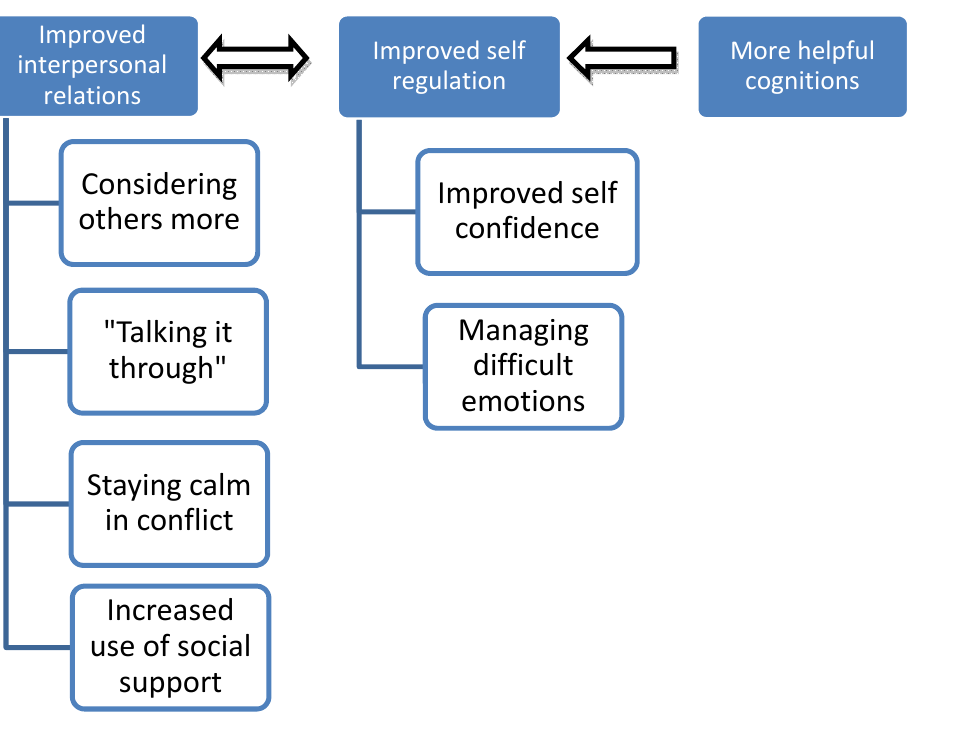
Figure 1. Themes and sub-themes of perceived changes attributed to participation in